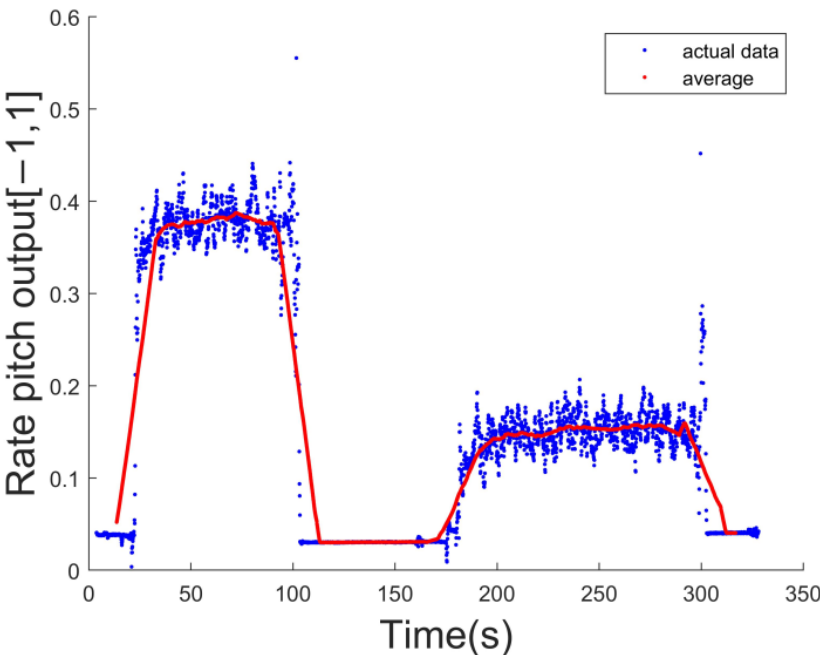
Figure 16. The output control quantity at preparation state and flight state.